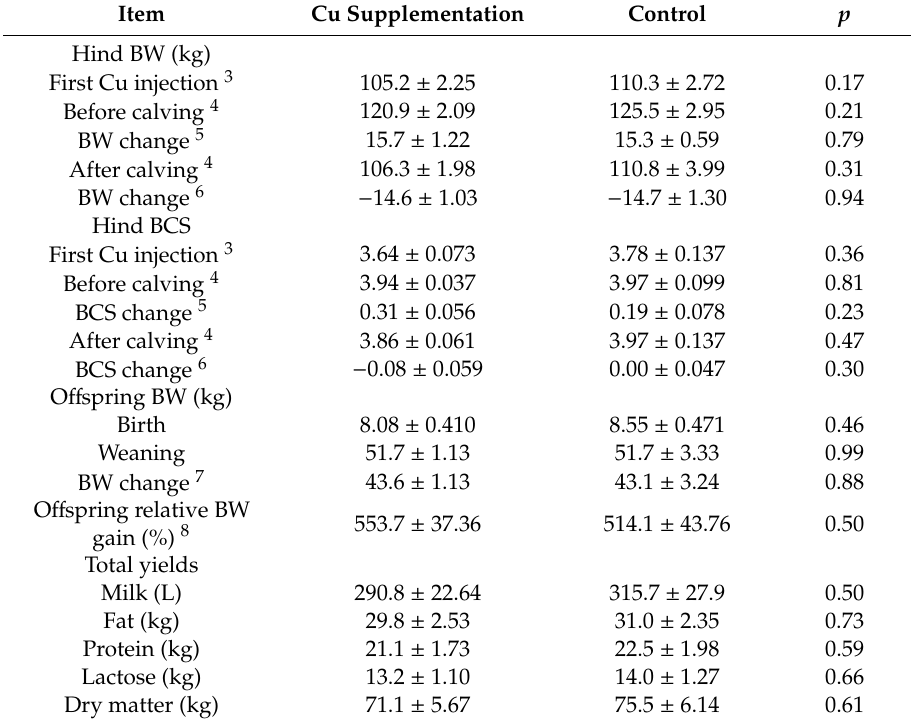
Table 1. E ff ects of parenteral Cu supplementation 1 of late-gestating and lactating Iberian red deer hinds fed a balanced diet on body weight (BW) of hind and o ff spring and body condition score (BCS) of hind and total yields. Data are means ± standard error of mean 2